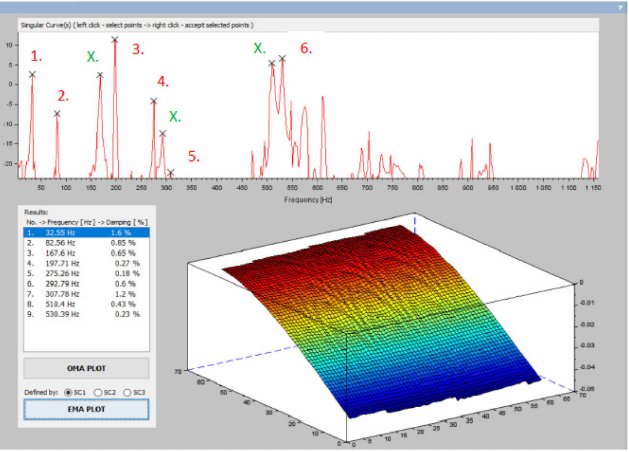
Figure 13. Resulting modal parameters obtained with the application module. Each natural frequency has its own specific mode of oscillation. The individual mode shapes with their respective frequencies are shown in Figure 14.